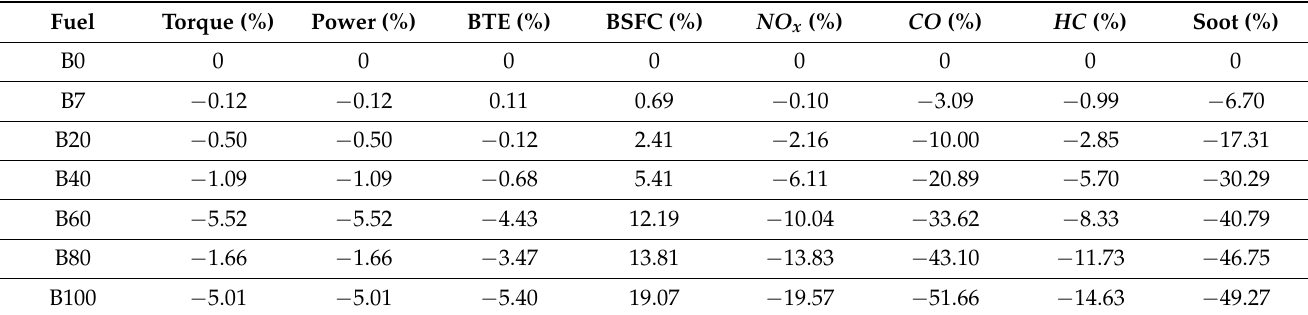
Table 5. The effect of changing the proportion of biodiesel on the performance and emissions at the rated speed compared to that of pure diesel (in %).